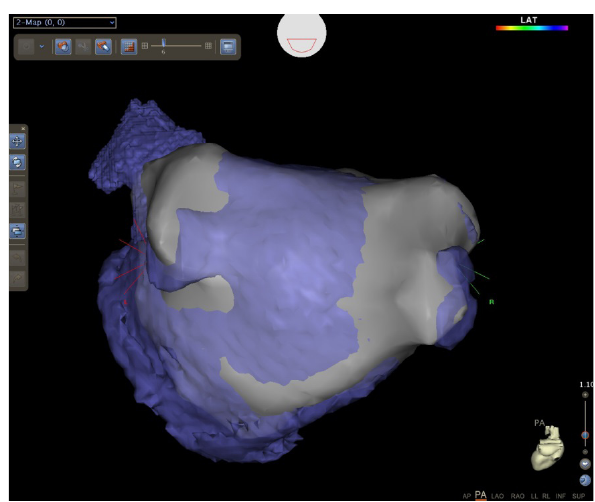
Fig. 2. Merge of left atrium maps: the blue map is the 3D MDCT model, the gray map is the electro-anatomic map.